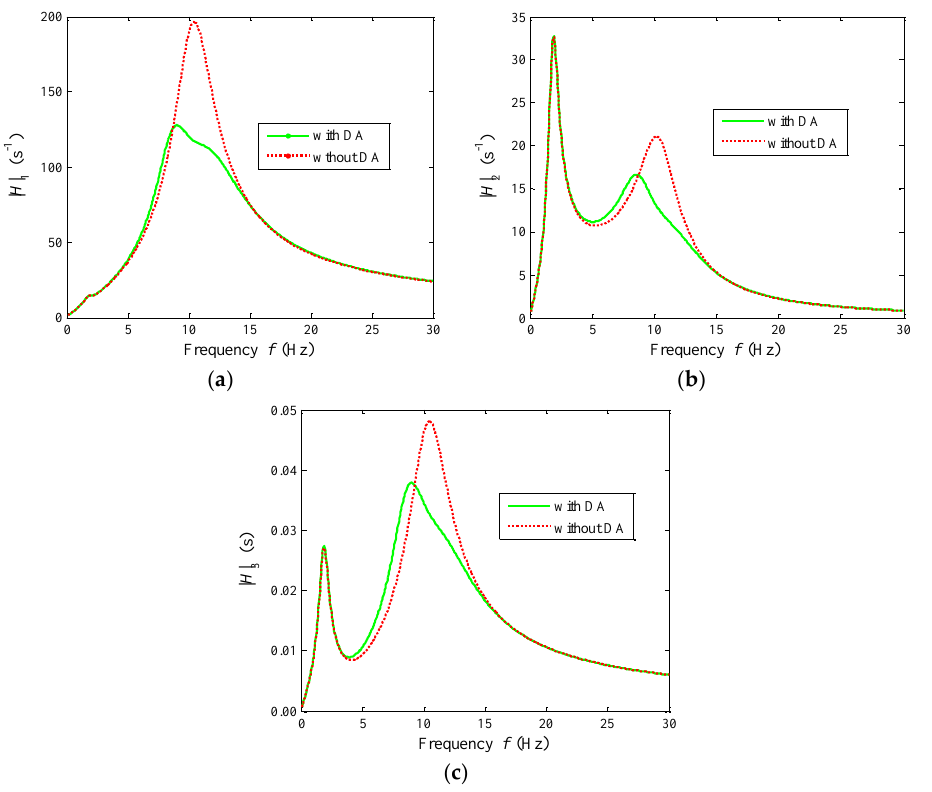
Figure 9. A comparison of the amplitude frequency characteristics of the system with the DA and without the DA: ( a ) | H 1 | for the wheelchair versus f ; ( b ) | H 2 | for the human versus f ; ( c ) | H 3 | for the tire versus f .